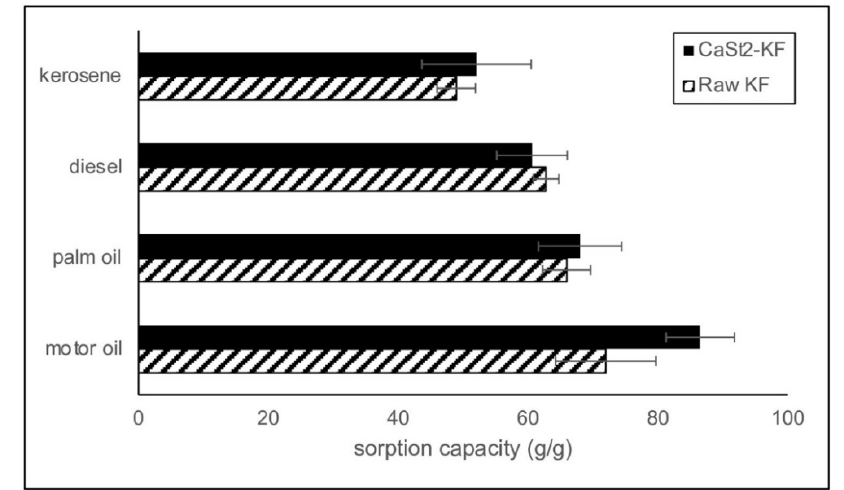
Figure 6. Comparison of the sorption capacities of CaSt 2 -KF and raw-KF in various model oils.